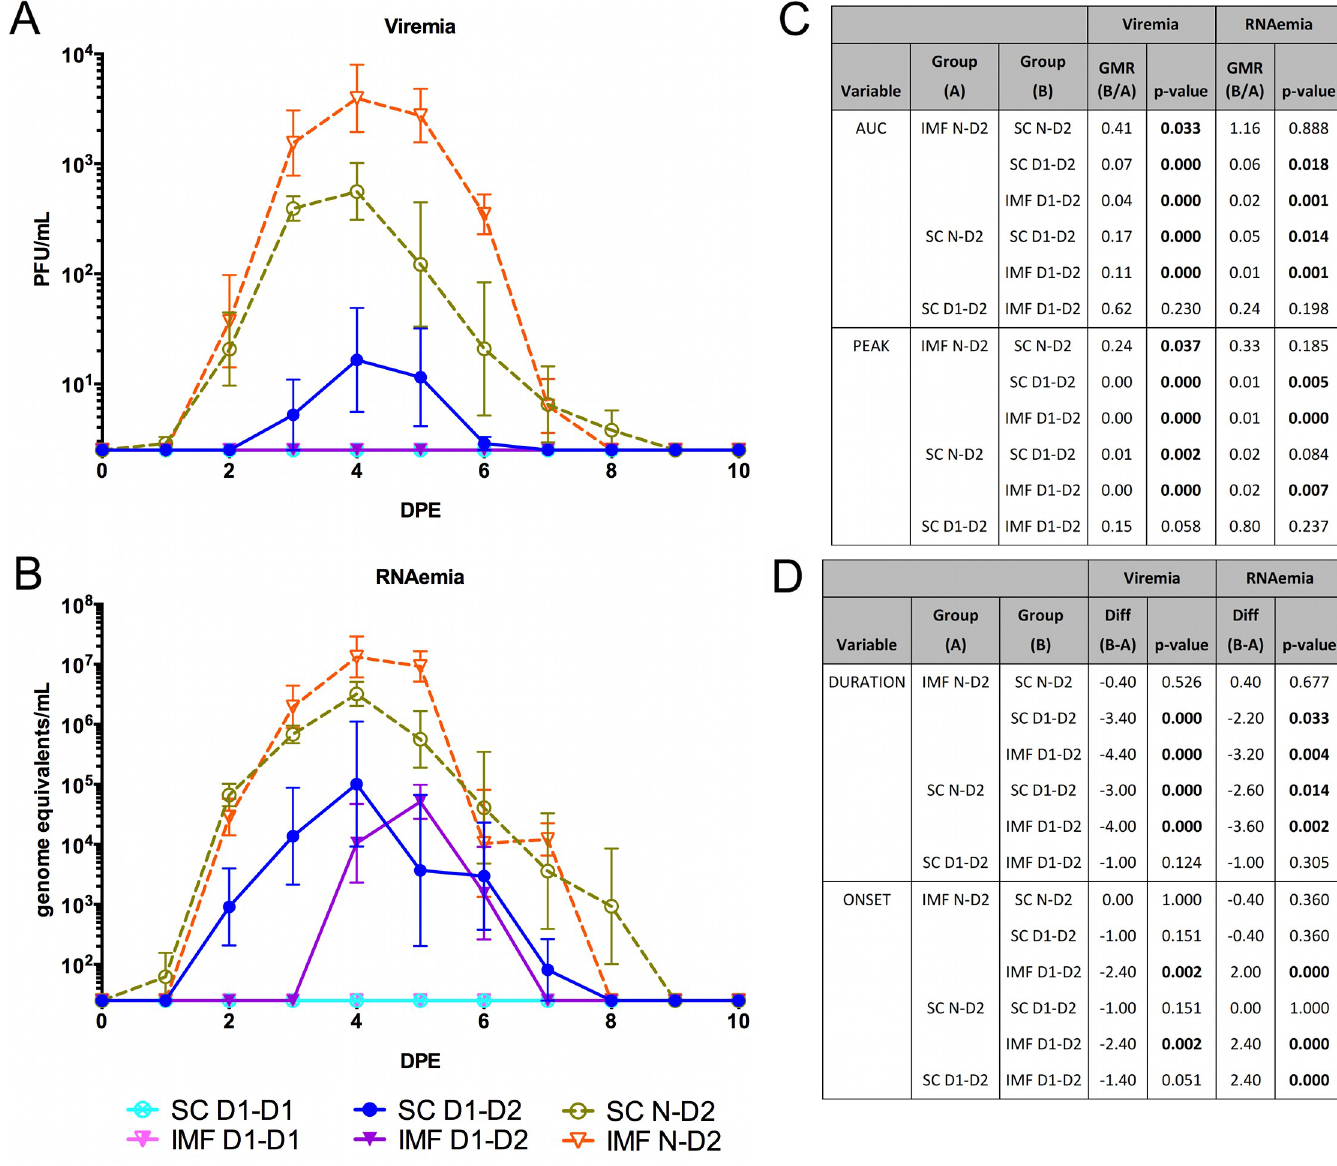
DENV-2 exposures (Figs 2B and S1B). Similar to primary DENV-1 exposures, HCT decreased and percent monocytes increased significantly in both SC N-D2 and IMF N-D2 groups on day 7 relative to baseline. Contrary to primary DENV-1 exposures, WBC counts in SC N-D2 and